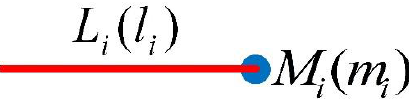
Figure 27. One of blade segments model.